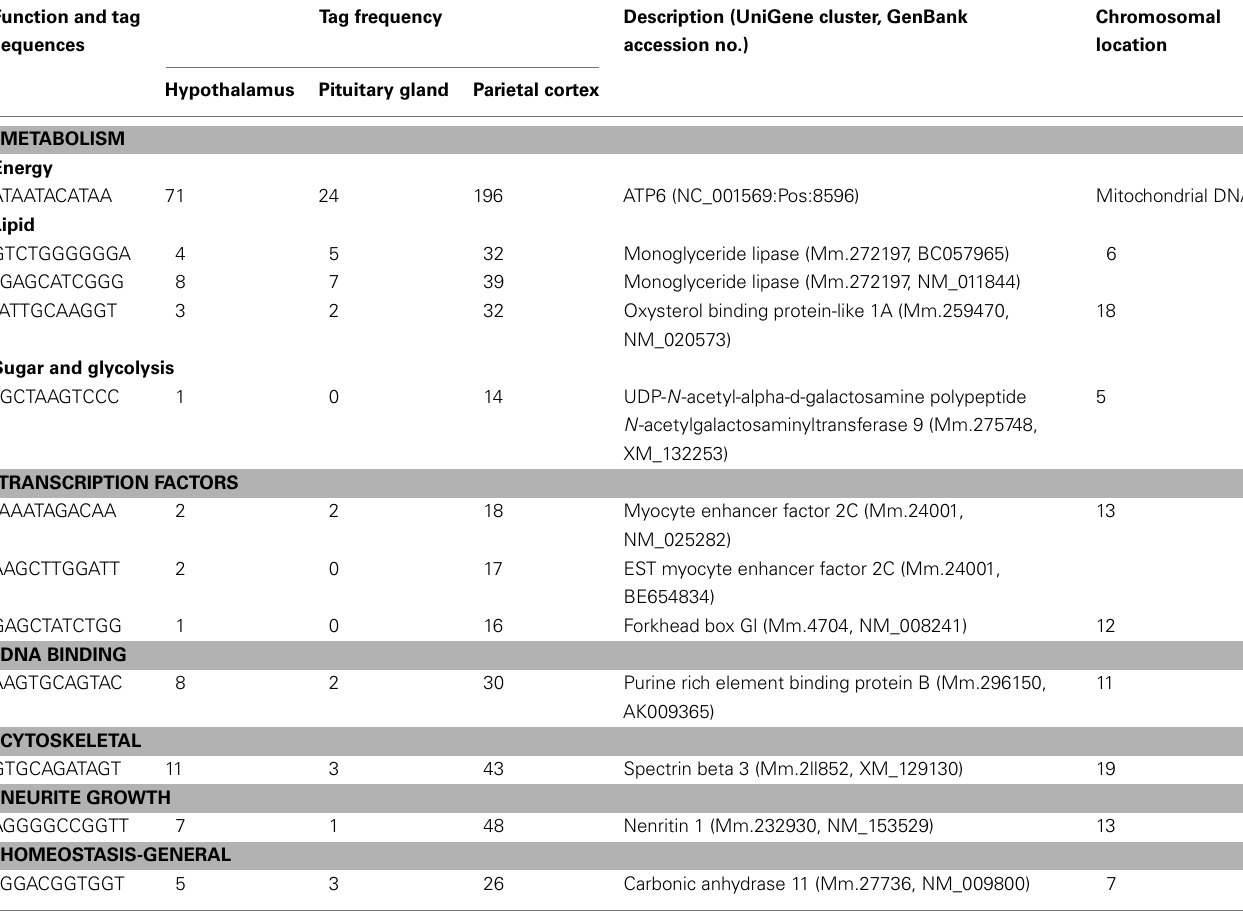
TableA2 | Components of metabolism, gene expression, and others preferentially expressed in the cortex. Function and tag